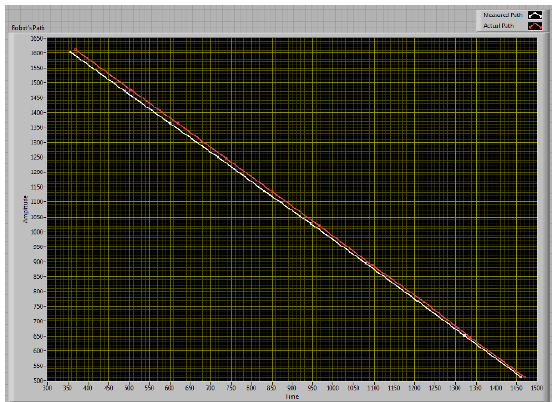
Figure 13. Robot Path Tracking of prescribed vehicle trajectory (the white line) on Testbed